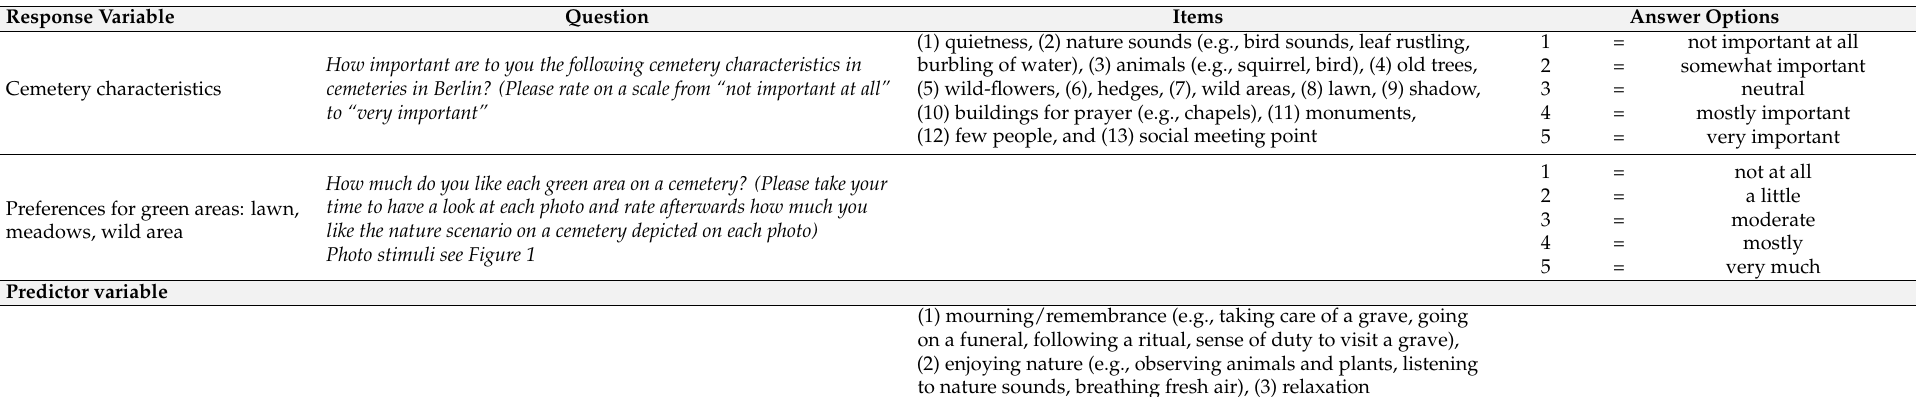
Table 1. Tabular summary of the response variables that were used in the